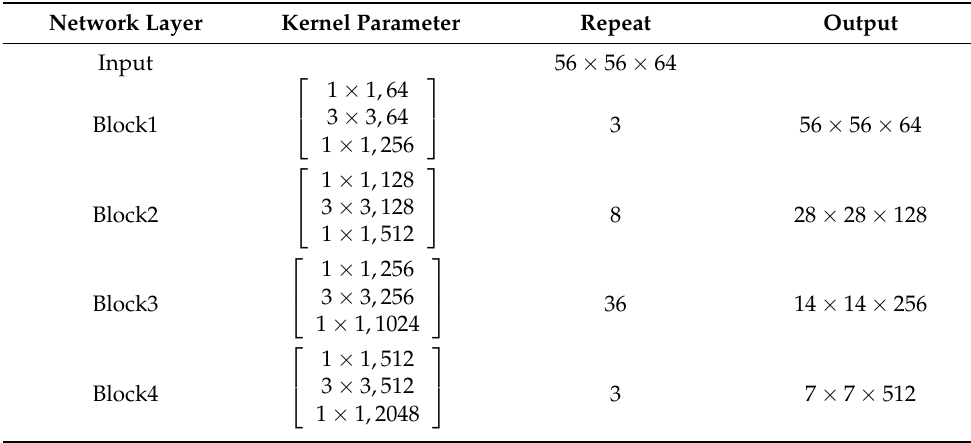
Table 1. Detailed parameters of hourglass structure. Network